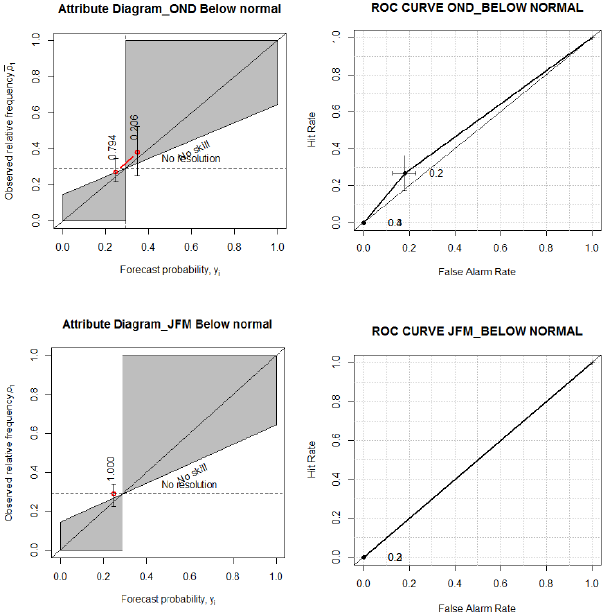
Figure 5. The attributes diagrams and the ROC curves for early and late season forecasts, based on in-situ observations for verification. The confidence intervals are calculated using the standard bootstrap ( n = 1000).